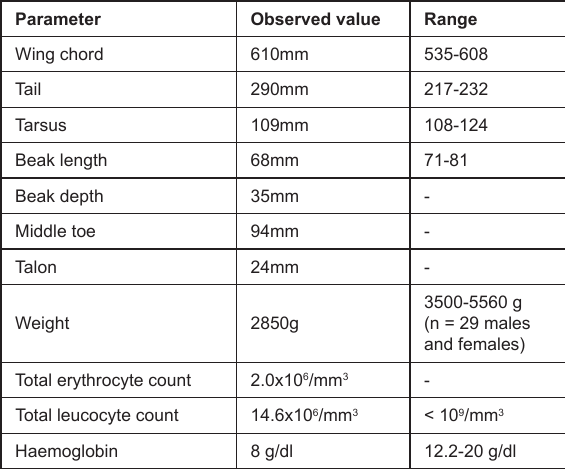
(Ranges for biometry parameters are as per Ali & Ripley 1969; ranges for haematological parameters are as per Coles